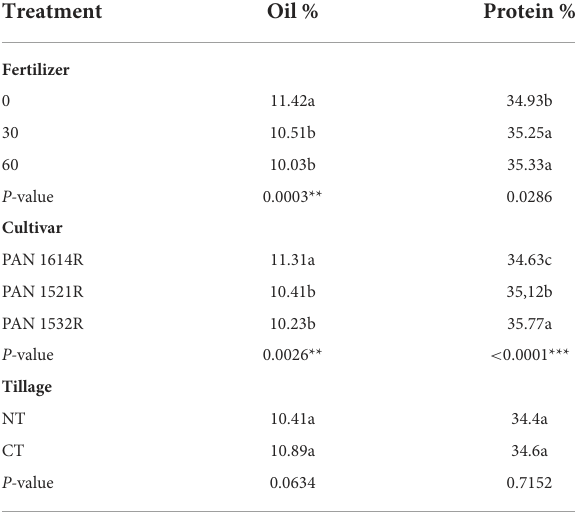
TABLE 8 Effects of fertilizer, cultivar and tillage on oil and protein content on a soybean cropping system.